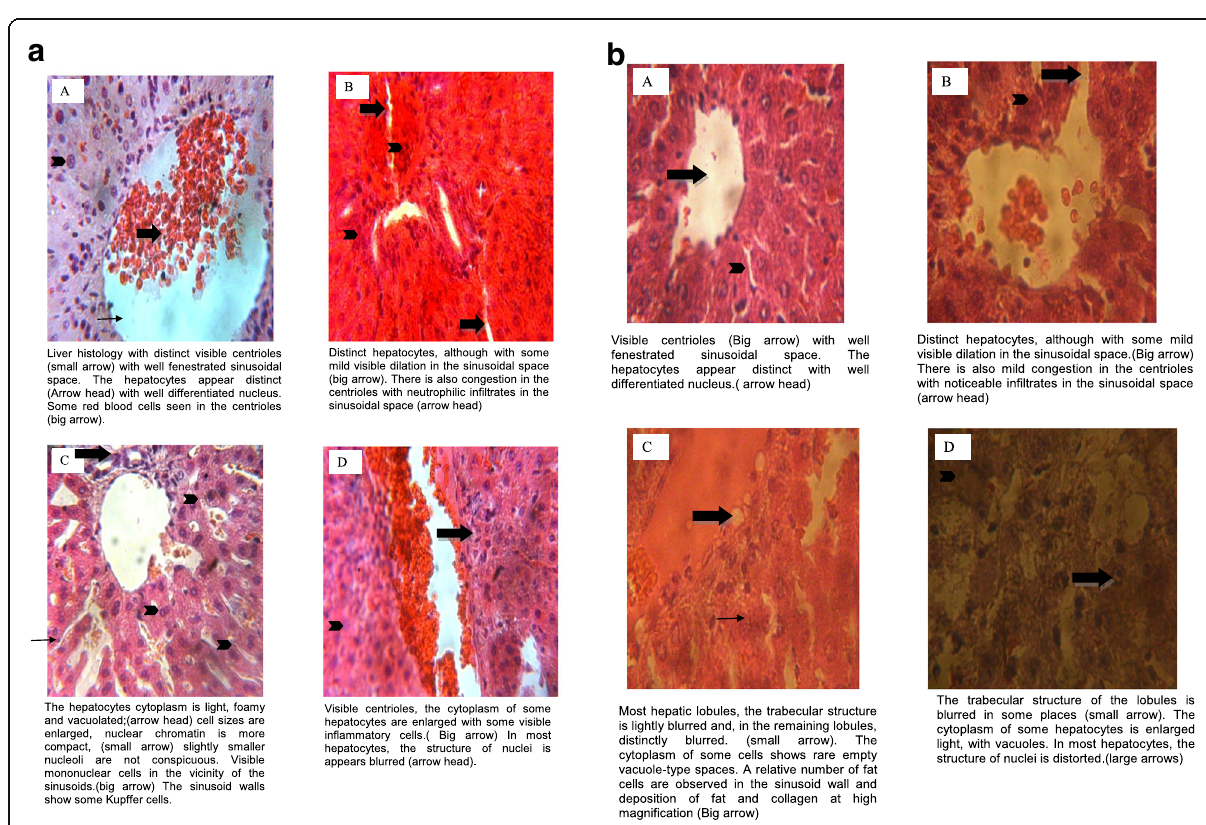
Fig. 1 a Morphological changes in the liver of rats exposed to contaminated diet after 1-month exposure. (A) Control. (B) Cd-contaminated diet. (C) As-contaminated diet. (D) Cd + As-contaminated diet. b Morphological changes in the liver of rats exposed to contaminated diet after 3-month exposure. (A) Control. (B) Cd-contaminated diet. (C) As-contaminated diet. (D) Cd + As-contaminated